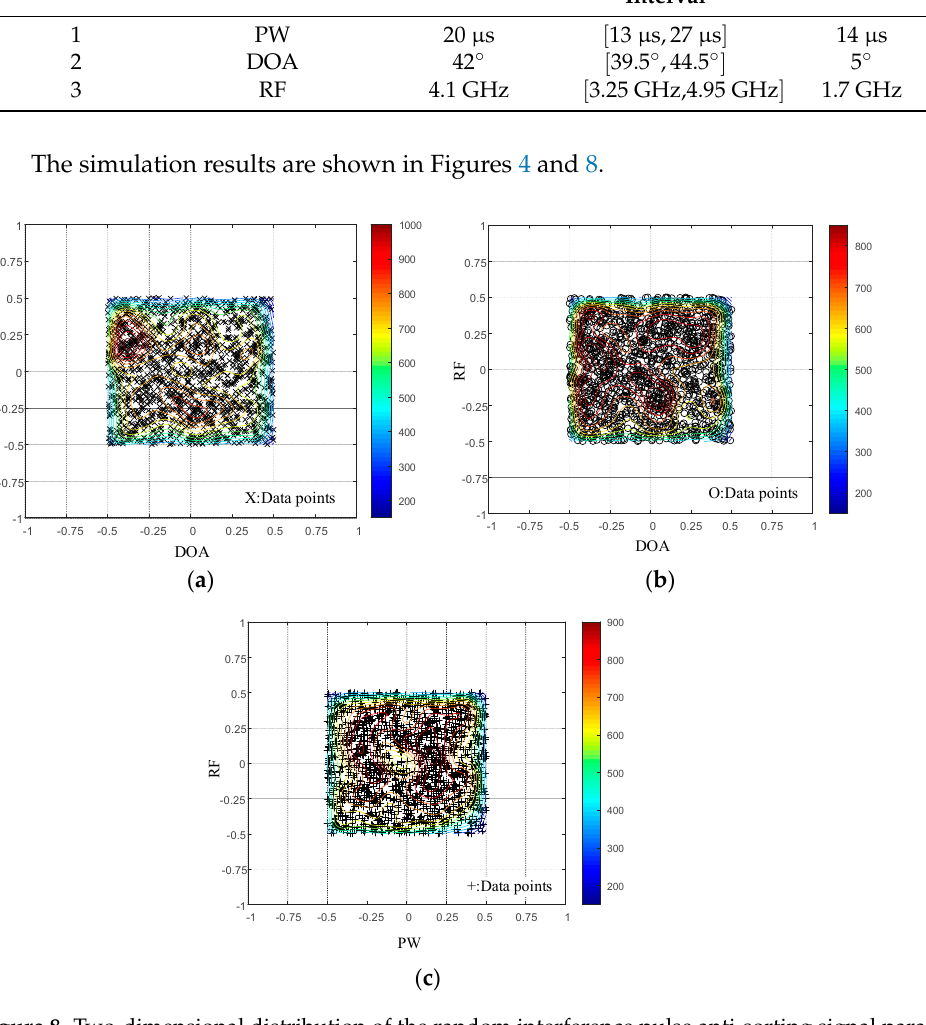
Figure 8. Two-dimensional distribution of the random interference pulse anti-sorting signal parame- ter equipotential lines. ( a ) Two-dimensional diagram of the PW-DOA equipotential line. ( b ) Two- dimensional diagram of the RF-DOA equipotential line. ( c ) Two-dimensional diagram of the RF-PW equipotential